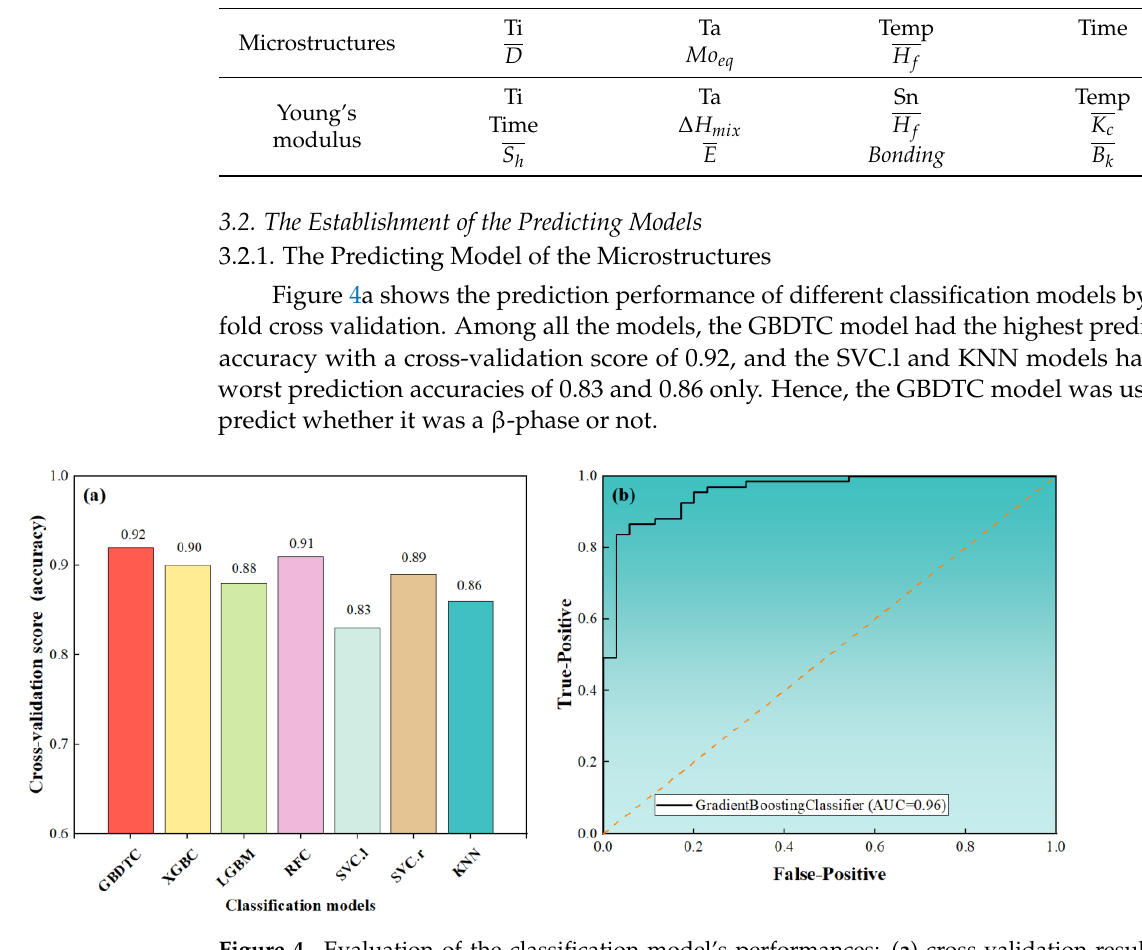
Figure 4. Evaluation of the classification model’s performances: ( a ) cross-validation results un- der different classification models and ( b ) ROC curve distribution of the GBDTC model on the testing